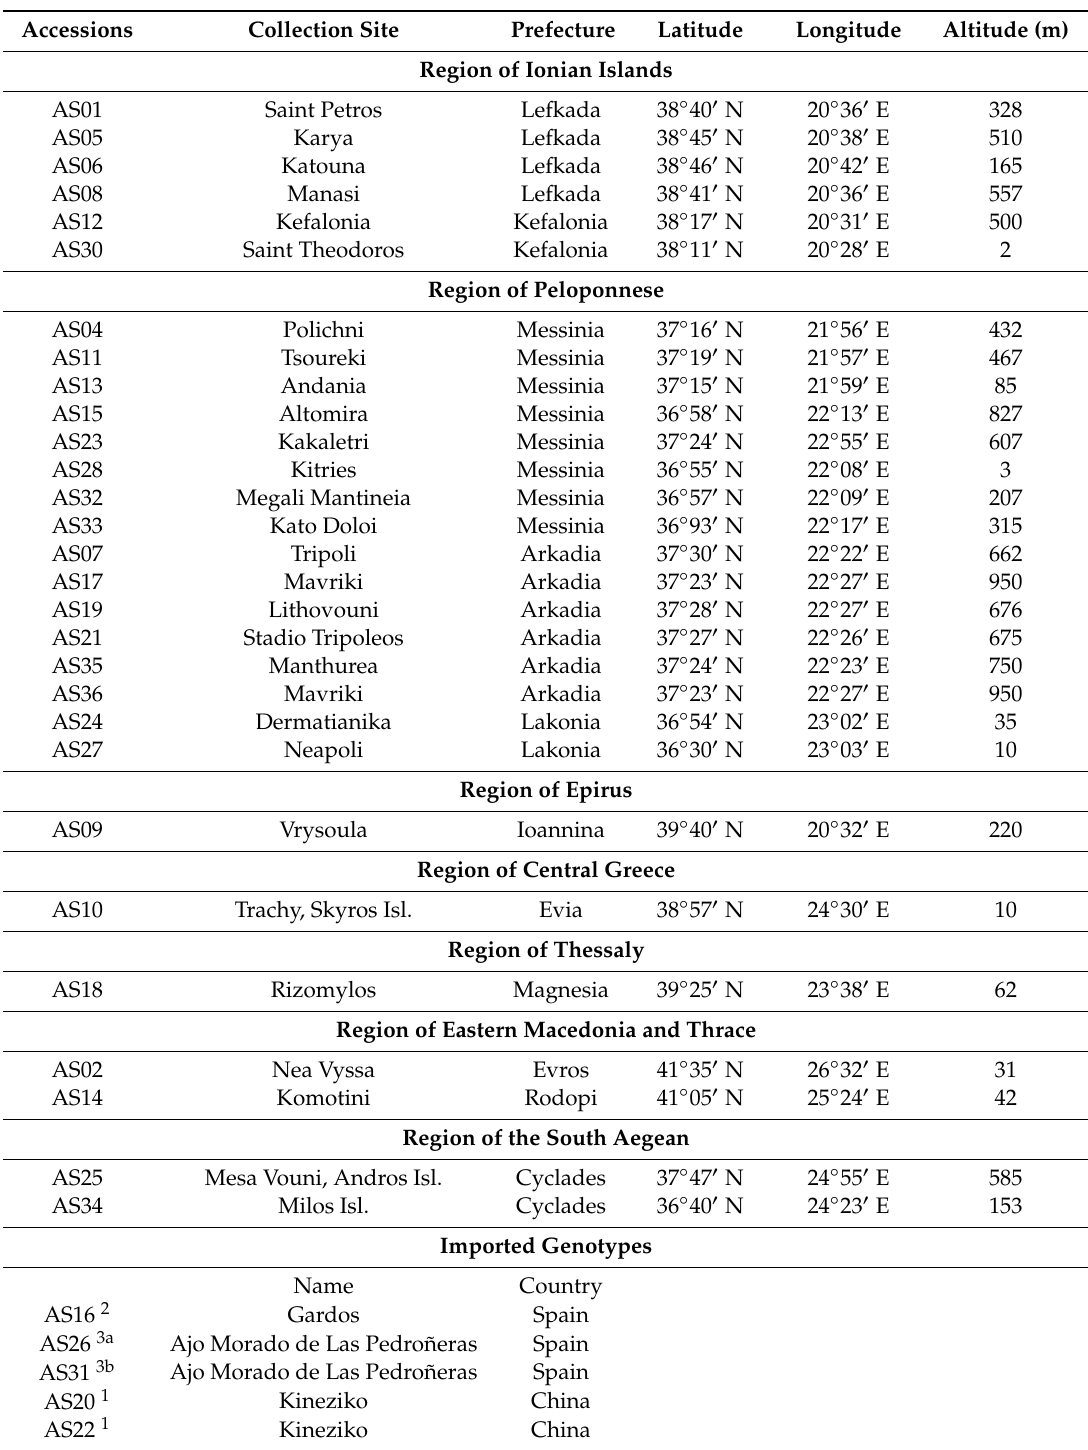
Table 1. Geographical distribution and collection sites of the garlic